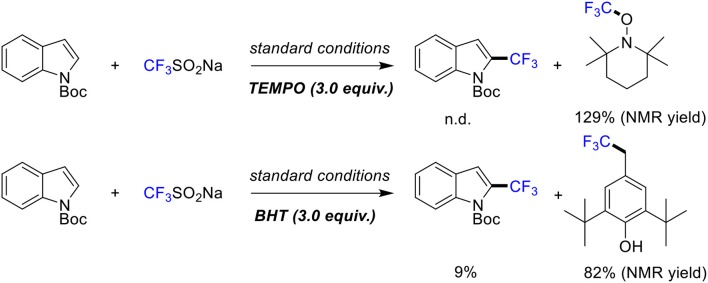
Mechanistic study.